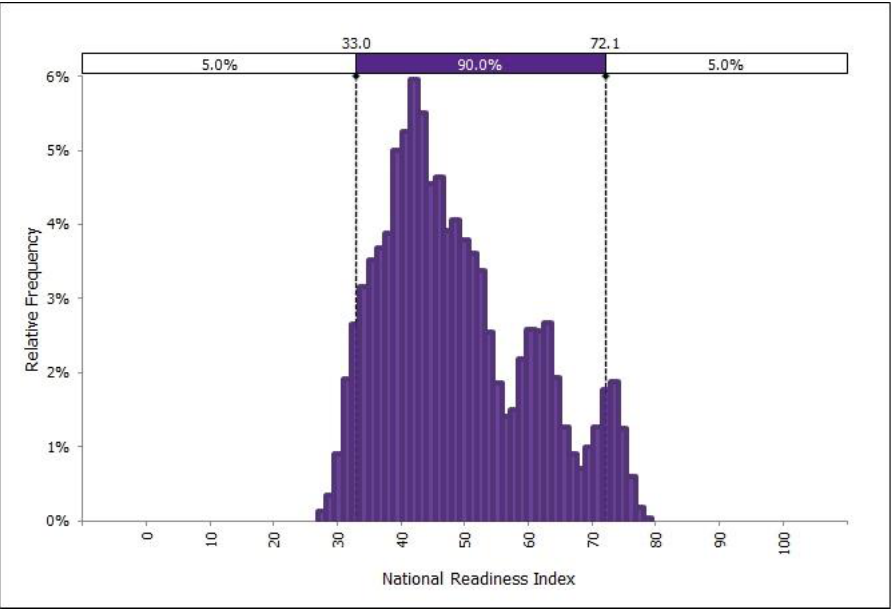
Figure 5. National Readiness Index, across all agencies across all components. This index is con- strained by the minimum agency readiness component of each agency over all agencies.